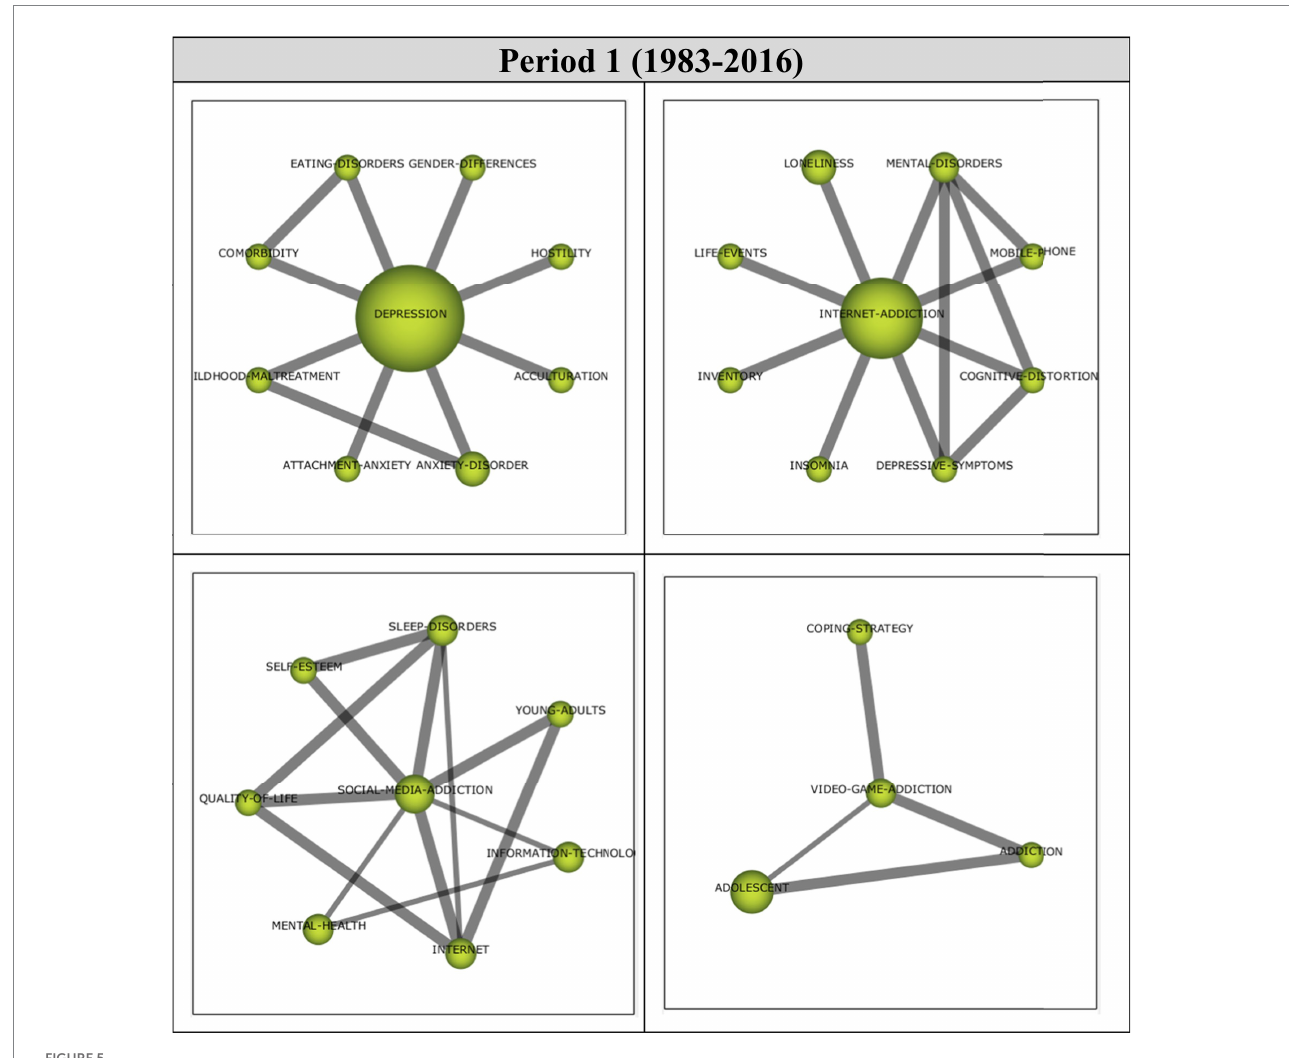
FIGURE 5 Thematic network